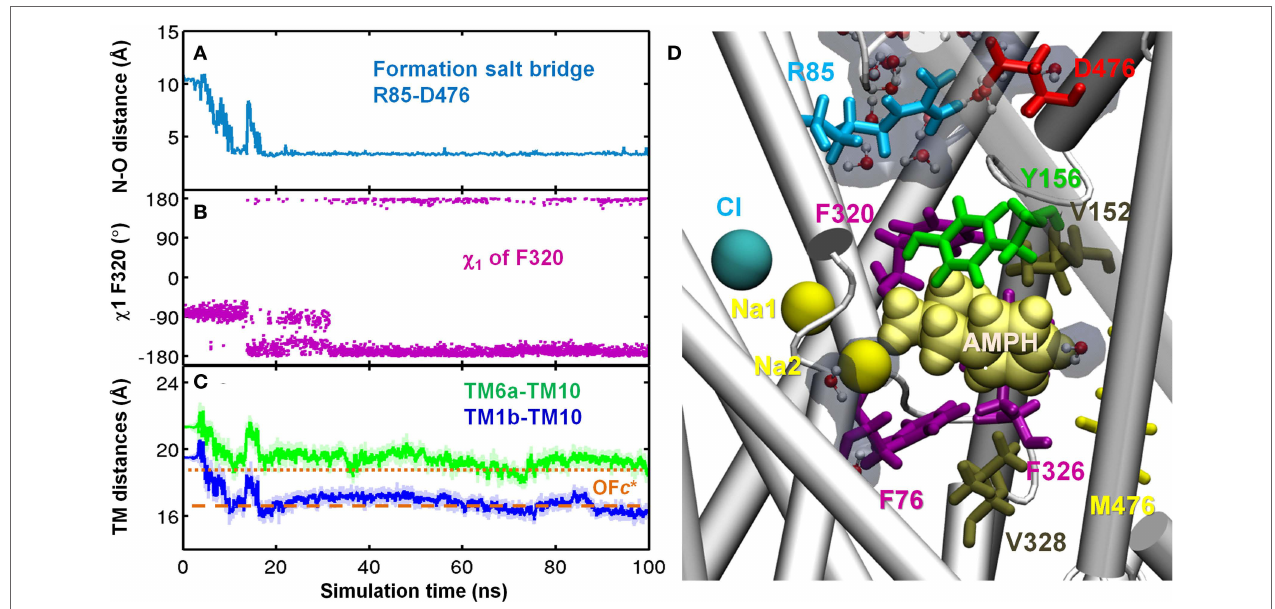
binding site for AMPH (yellow vDW) was dehydrated and occluded Figure 6 | aMPh binding to site s1 facilitates hDaT structural to both EC and IC region. Two hydrophobic layers F320-V152 (upper) transition from outward-facing open (OF o ) to outward-facing and F76-F326-V328 (lower) prevent water penetration from both closed (OF c *) state . Time evolutions of (a) N–O distance of R85-D476. sides. Water molecules in the EC and IC vestibules are shown in Salt-bridge was formed around 20 ns; (B) χ of F320. F320 flipped on 1 CPK format with semi-transparent cyan. Results were taken from top of dopamine as χ stably changed from -80 ± 15° to 170 ± 15° 1 run AMPH-bound-1 . Transition from OF o to OF c * was also observed in around 35 ns; (c) CoM distances of EC-exposed TM segments TM6a–TM10 AMPH-bound-2 (green) and TM1b–TM10 (blue). (D) In the OF c * state, side view of the